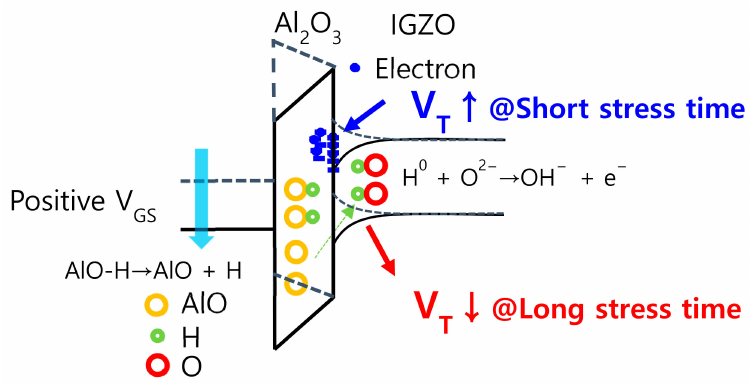
Figure 3. Schematic energy band diagram which illustrates the e ff ects of electron trapping and hydrogen release and di ff usion on the V TH of IGZO TFTs.